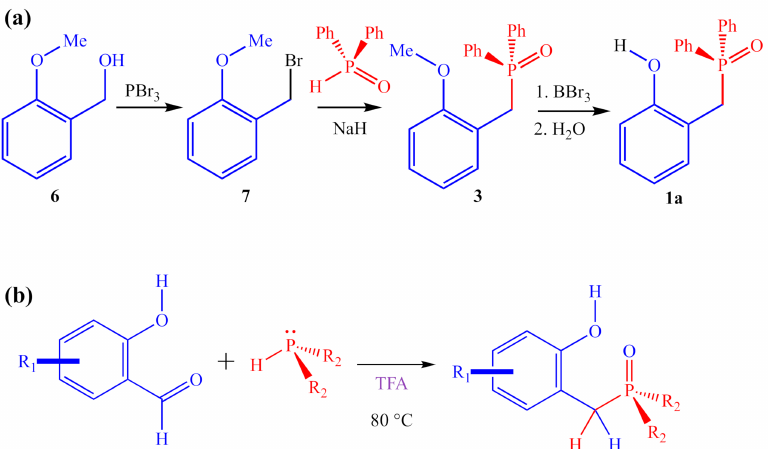
Figure 5. ( a ) Multi-step synthesis of 1a reported by Denton and co-workers; ( b ) ARC synthesis to access diverse array of 2-HOBPOs in a single